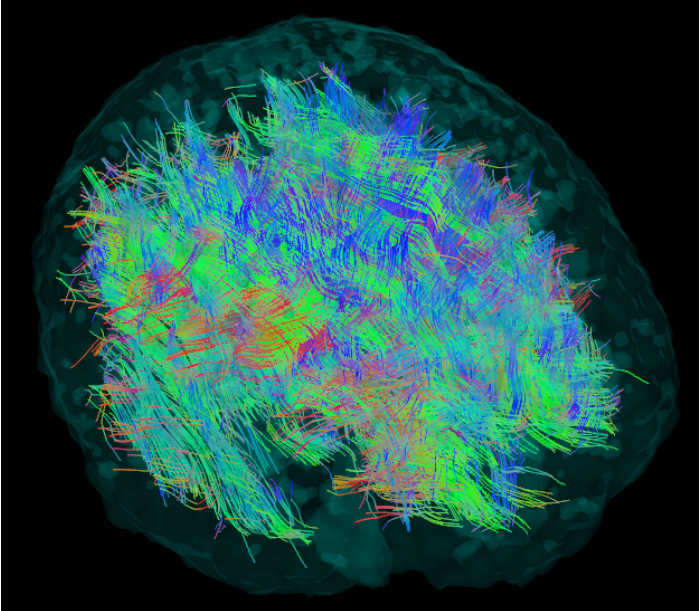
Figure 1. The result of the tractography phase. Note the fibers starting and ending on the outer surface, the cortex of the brain, which consists of gray matter. The fibers are tracked only in the anisotropic white matter.